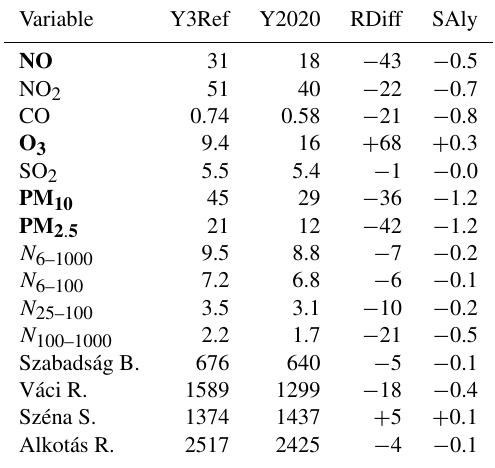
Table 2. Median atmospheric concentrations of NO, NO 2 (both